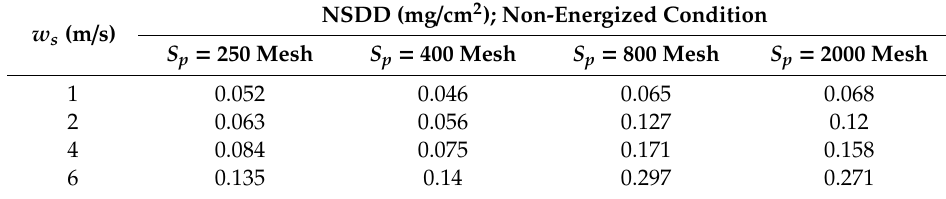
Table 5. NSDD under Non-energized